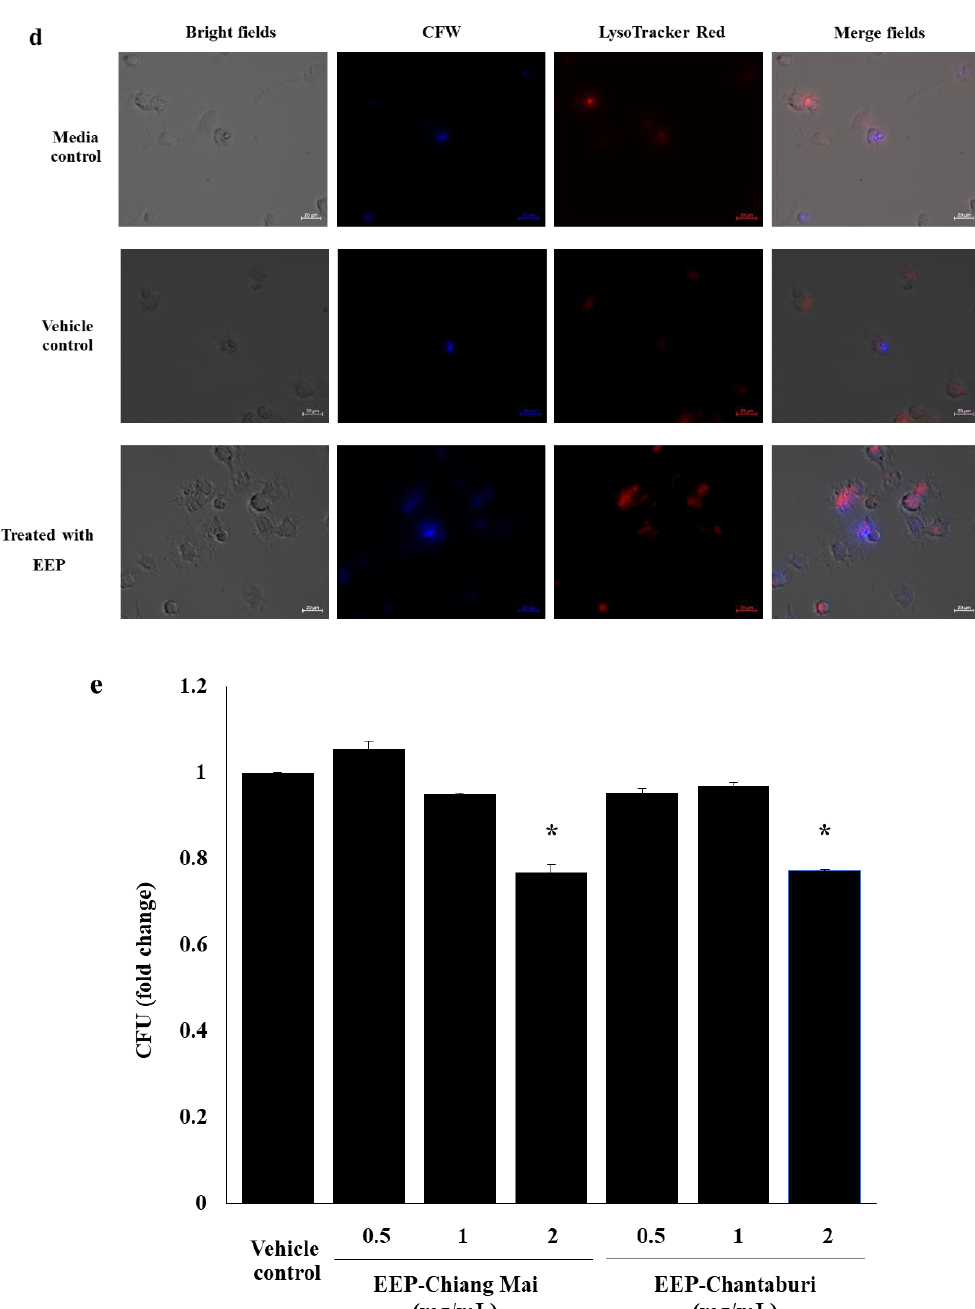
Figure 5. Anti-proliferative e ff ect of EEP on C. neoformans phagocytosis by RAW 264.7 macrophages. EEP-treated yeast cells were opsonized with anti-GXM mAb (Clone 18b7) prior to infection for various time points. ( a ) Infected macrophages with C. neoformans were stained with Wright-Giemsa staining. ( b , c ) Intracellular proliferation of untreated and EEP-treated C. neoformans after infection for 24 h. Mother cells—bright blue color (red arrow), daughter cells—dim color (white arrow). Scale bar represents 20 µm (magnification × 400). ( d ) Localization of C. neoformans to phagolysosomes. Infected macrophage cells were stained with LysoTracker Red and observed under inverted fluorescence microscope. Scale bars represent 20 µm. ( e ) Intracellular survival of EEP-treated C. neoformans . Macrophage cells were lysed using lysis medium and intracellular cryptococcal proliferation were counted by colony-forming units (CFUs) and shown as fold change. The data represent the mean ± standard error of the mean (SEM) of at least three independent experiments. Significant di ff erences (* p < 0.05) when compared with the vehicle control were determined by one-way ANOVA with the Tukey-Kramer multiple comparisons